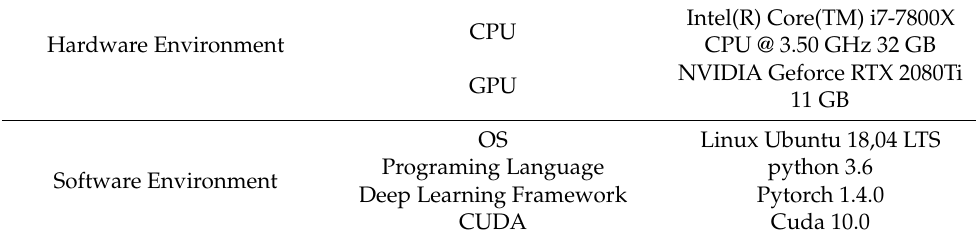
Table 1. The software and hardware environment used in the